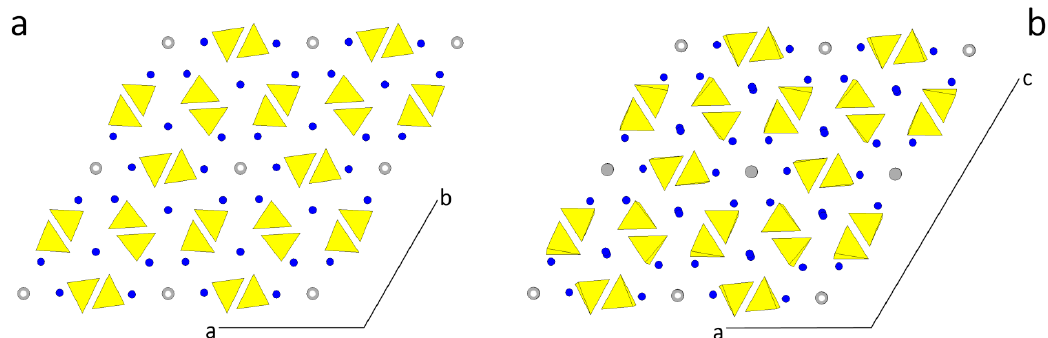
Figure 1. ( a ) The P6 3 /m setting of a HAp crystal showing the perfect hexagonality of the [001] zone, being the axial parameters a 0 = b 0 ; ( b ) In the setting P2 1 /c, the alternating up-down OH − dipoles in contiguous channels markedly outline the monoclinicity of the structure. The [010] direction coincides with the 2 1 axis and is perpendicular to the plane of the drawing, according to the convention adopted in [38].